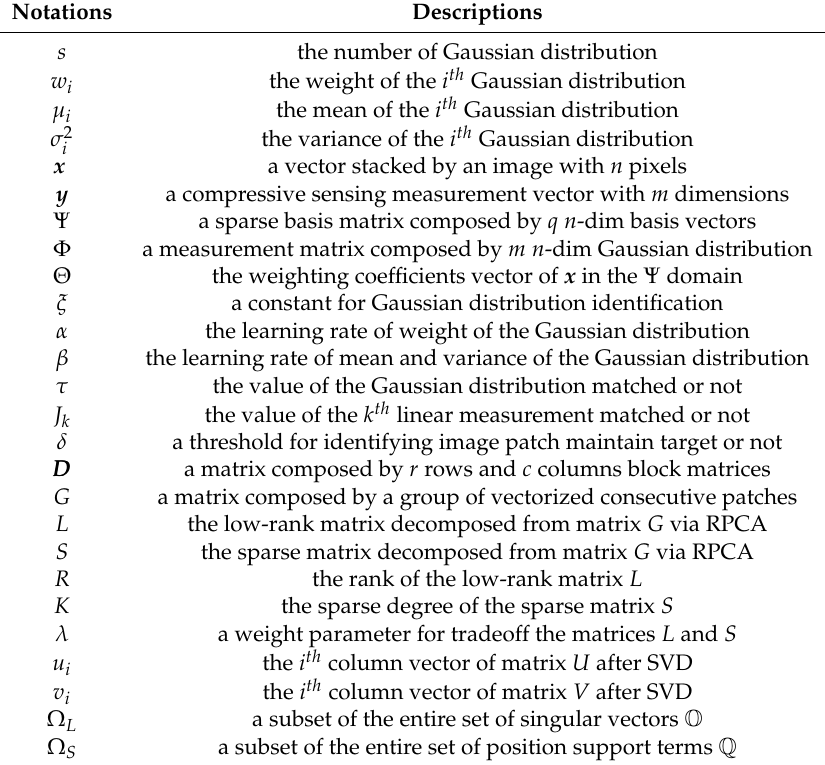
Table 1. A brief summary of the notations used throughout the rest of this